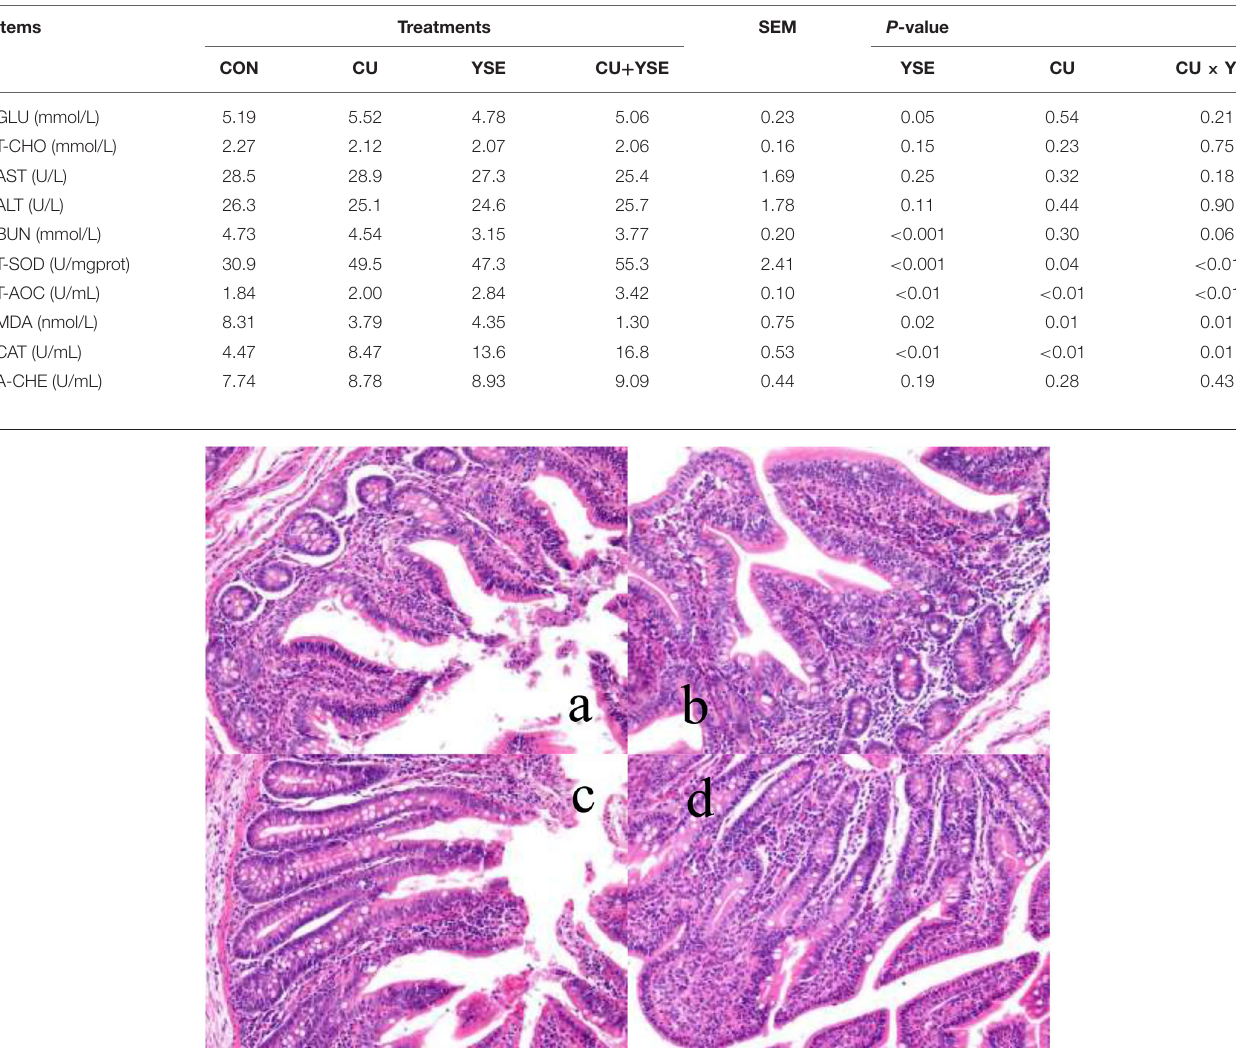
TABLE 5 | Effects of dietary YSE and oral CU on serum parameters in weaned piglets. Items Treatments SEM P -value